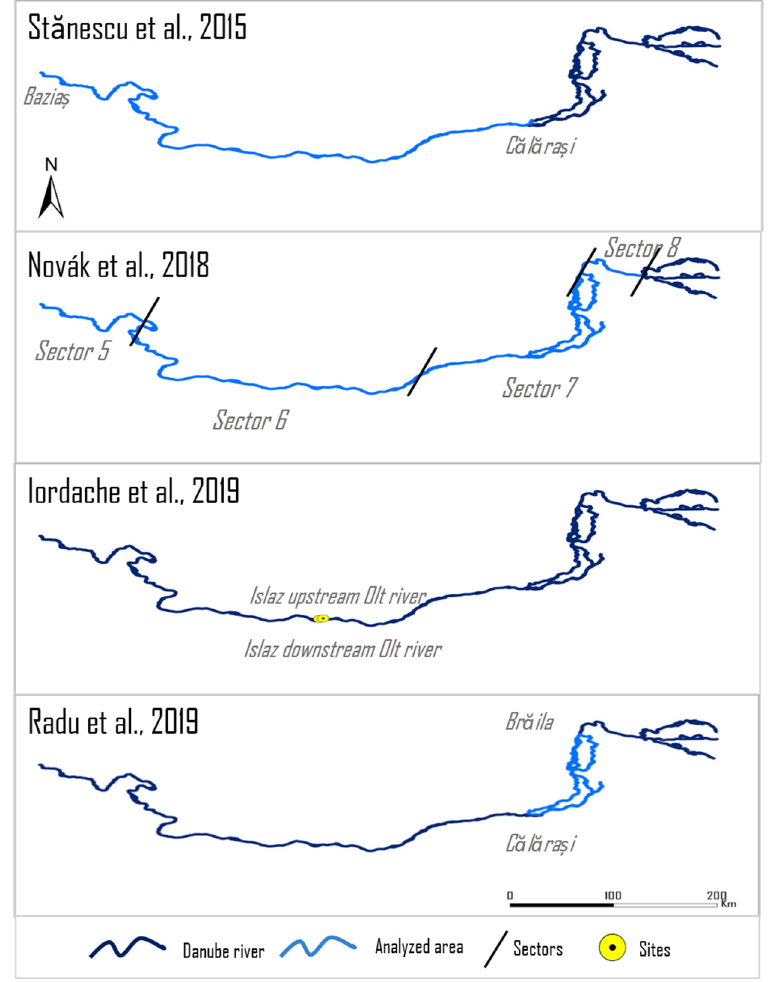
Figure 8. The sites and sections sampled and analyzed in certain stretches of the Romanian Danube [34,57,61,62]